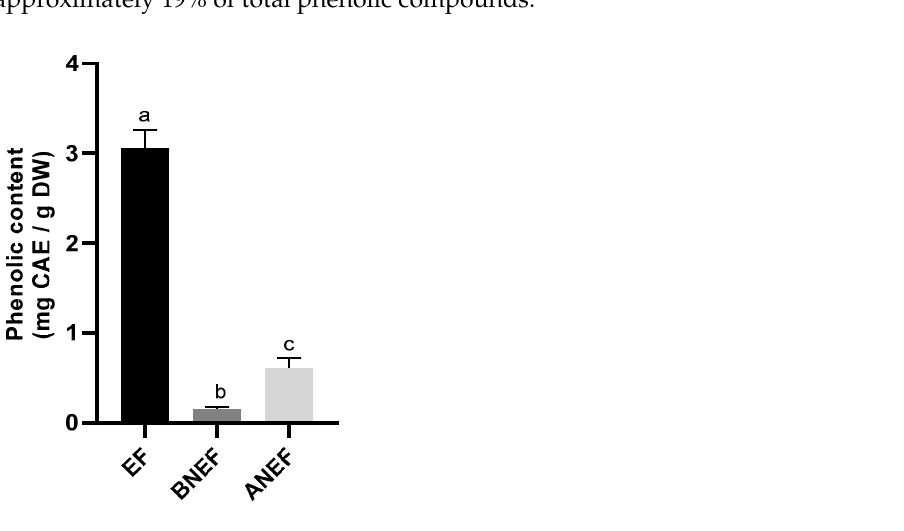
Figure 1. Extractable (EF) and non-extractable phenolic content (BNEF and ANEF) of pear pomace. Columns with different letters are statistically different ( p < 0.05).